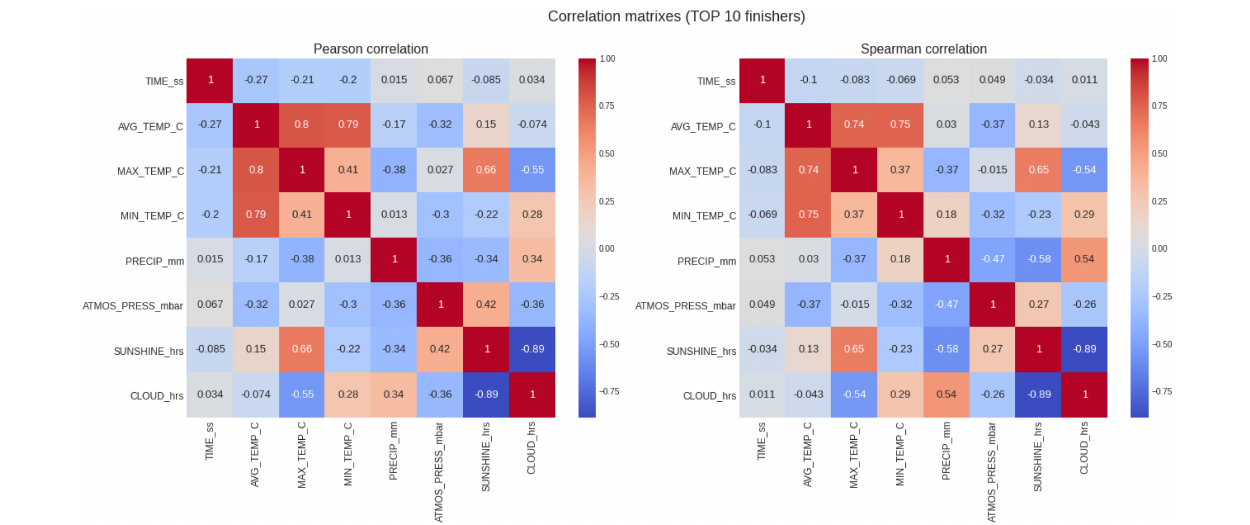
TABLE 5 | Top 100 marathon finishing times in relation to ambient conditions; mm (millimeter), mbar (millibar), C (degrees Celsius), SD (standard deviation). Marathon finish time (top 100 runners)